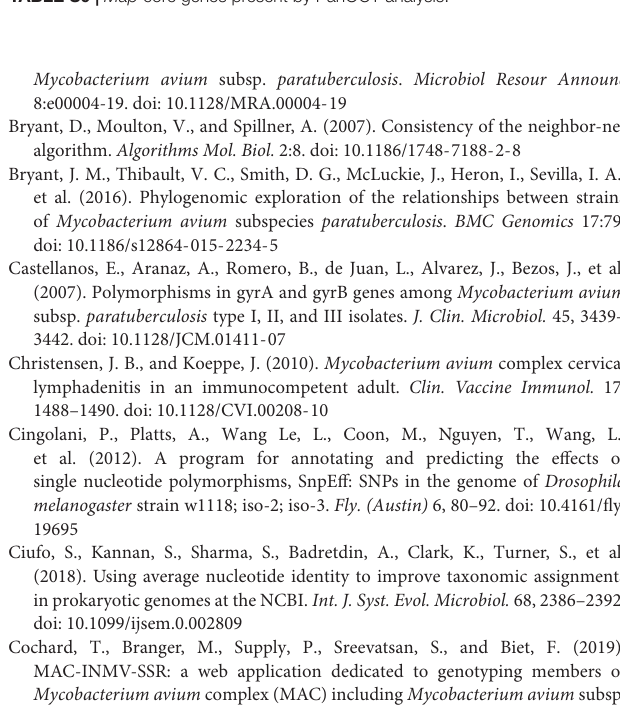
TABLE S6 | hsp65 sequevars among M. avium strains. Strain 104 was used as the reference in this analysis similar to Turenne et al., 2006. Nucleotides are shown